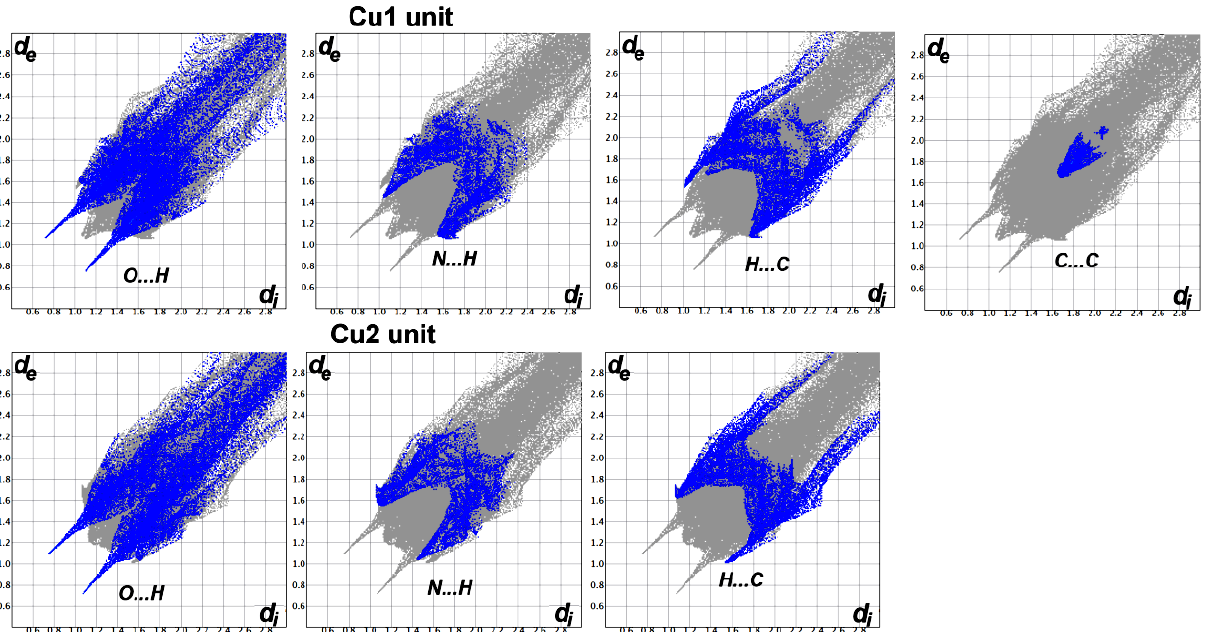
Figure 12. Decomposed fingerprint plots in complex 2 .